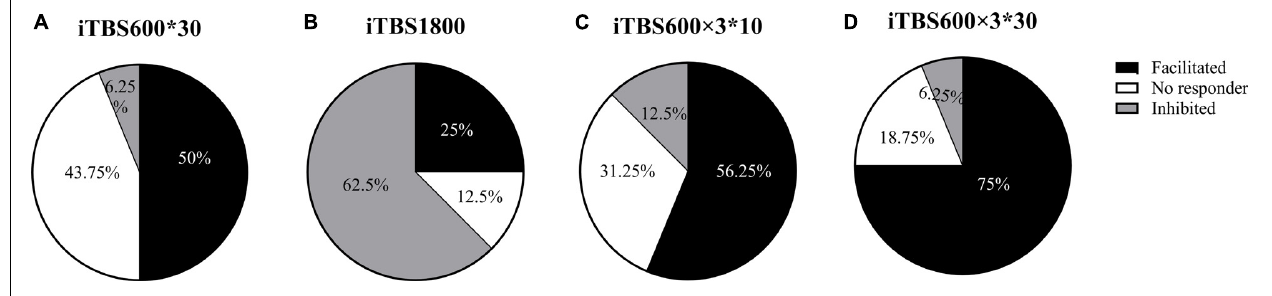
FIGURE 6 | The percentage of subjects that responded to different iTBS conditions. (A) one blocks of iTBS (B) iTBS1800 (C) iTBS600 × 3 ∗ 10 (D) iTBS600 × 3 ∗